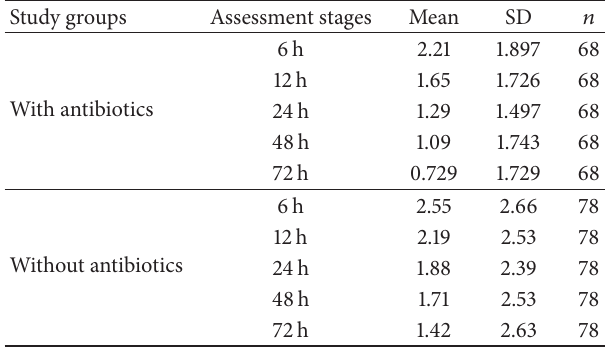
Table 1: Distribution of dry socket amongst males and females in both groups.